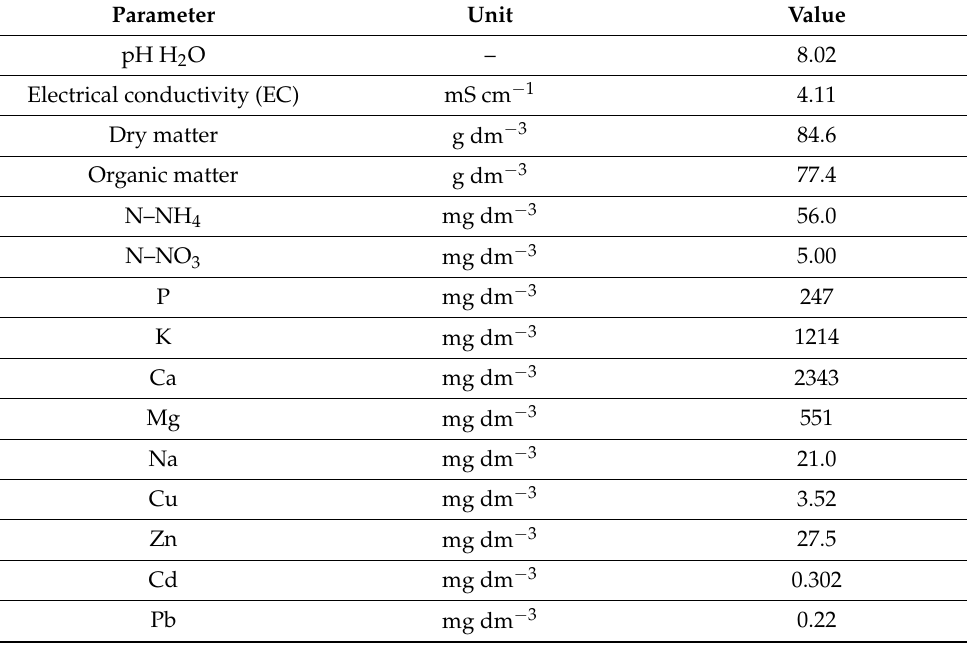
Table 1. Selected chemical properties of cavitated charcoal